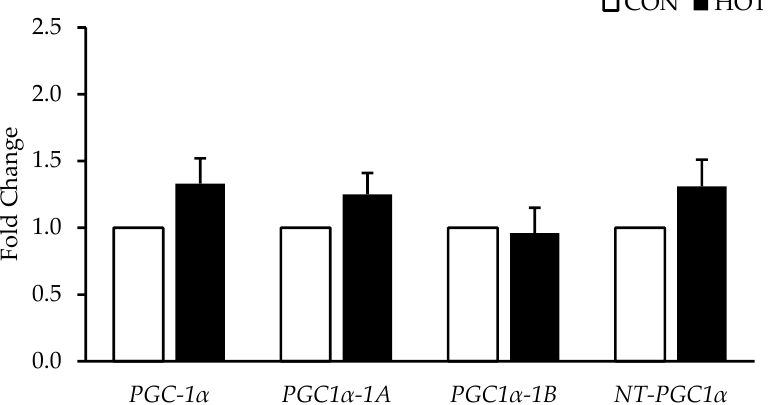
Figure 2. Genes Related to PGC-1 α mRNA Expression after 4 h in the control (CON) and heated (HOT) limbs. Data are mean ± SEM. HOT is expressed relative to CON (fold change = 1.0).